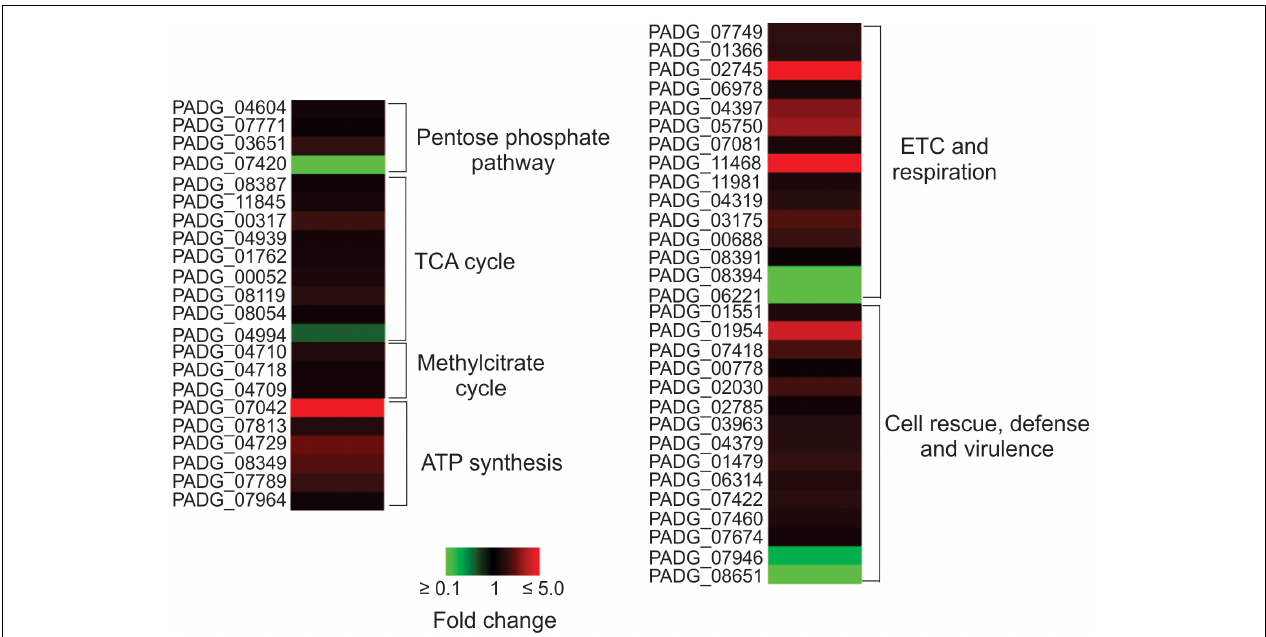
FIGURE 3 | Heat map showing the cellular processes predominantly up regulated in non-primed macrophages. The most up-regulated processes are ETC and ATP synthesis. TCA, tricarboxylic cicle acid; ETC, electron transport chain; PADG_04604, transketolase; PADG_07771, 6-phosphogluconolactonase; PADG_03651, 6-phosphogluconate dehydrogenase, decarboxylating 1; PADG_07420, transaldolase; PADG_08387, citrate synthase mitochondrial; PADG_11845, aconitate hydratase mitochondrial; PADG_00317, succinyl-CoA ligase subunit beta; PADG_04939, succinyl-CoA, 3-ketoacid-coenzyme A transferase; PADG_01762, oxoglutarate dehydrogenase; PADG_00052, succinate dehydrogenase [ubiquinone] flavoprotein, mitochondrial; PADG_08119, fumarate hydratase, mitochondrial; PADG_08054, malate dehydrogenase, NAD-dependent; PADG_04994, ATP-citrate-lyase; PADG_04710, 2-methylcitrate synthase, mitochondrial; PADG_04718, 2-methylcitrate dehydratase; PADG_04709, methyl-isocitrate lyase; PADG_07042, ATP synthase F1, delta subunit; PADG_07813, ATP synthase F1, gamma subunit; PADG_04729, ATP synthase subunit D, mitochondrial; PADG_08349, ATP synthase subunit beta, mitochondrial; PADG_07789, ATP synthase subunit delta, mitochondrial; PADG_07964, vacuolar ATP synthase subunit E; PADG_07749, NAD(P)H:quinone oxidoreductase, type IV; PADG_01366, NADH-ubiquinone oxidoreductase 1 alpha subcomplex subunit 5; PADG_02745, NADH-ubiquinone oxidoreductase Fe–S protein 6; PADG_06978, cytochrome C; PADG_04397, cytochrome c oxidase subunit 4, mitochondrial; PADG_05750, cytochrome c oxidase subunit; PADG_07081, electron transfer flavoprotein subunit alpha; PADG_11468, electron transfer flavoprotein beta-subunit; PADG_11981, V-type proton ATPase catalytic subunit A; PADG_04319, V-type ATPase, G